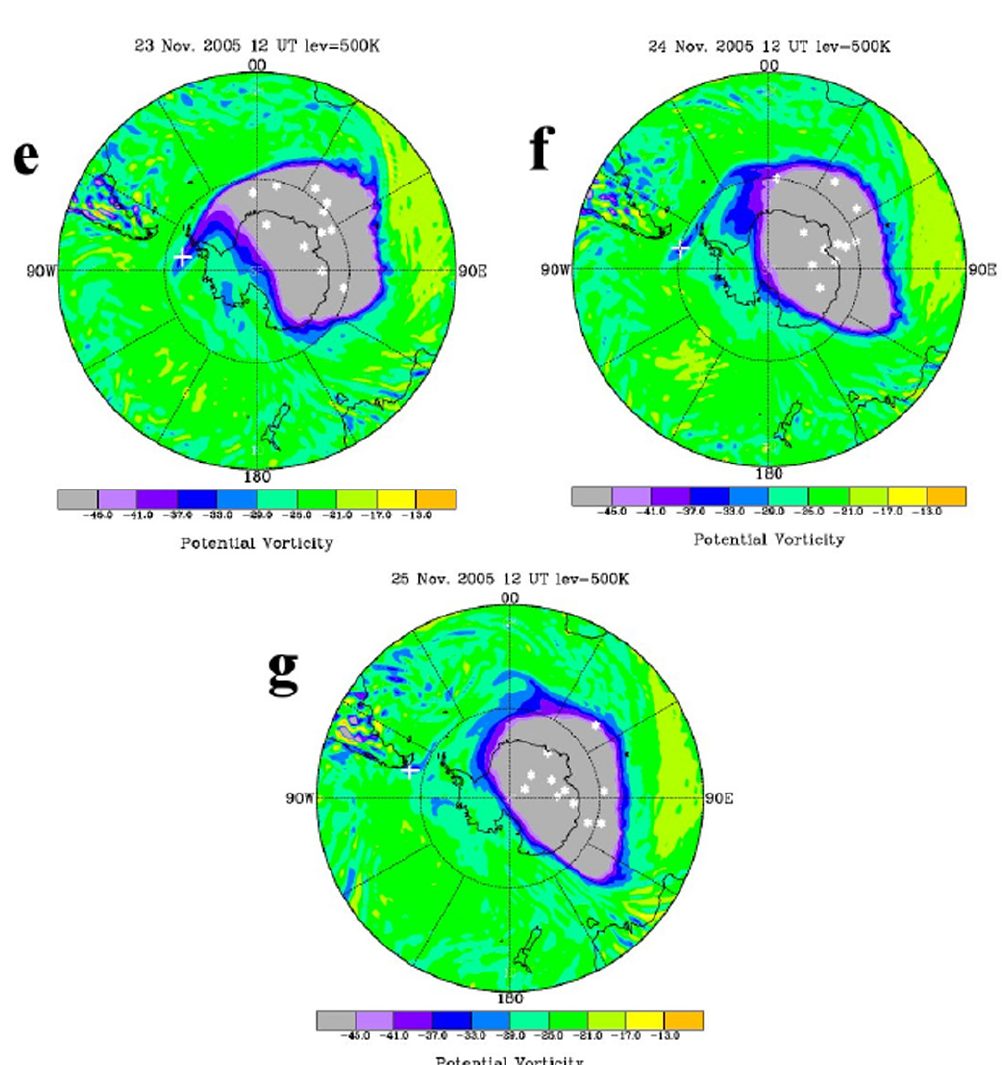
Fig. 1e–f. Same as Fig. 1a–d except that the potential vorticity fields are taken on (e) 23, (f) 24, and (g) 25 November 2005 at 12:00UTC.